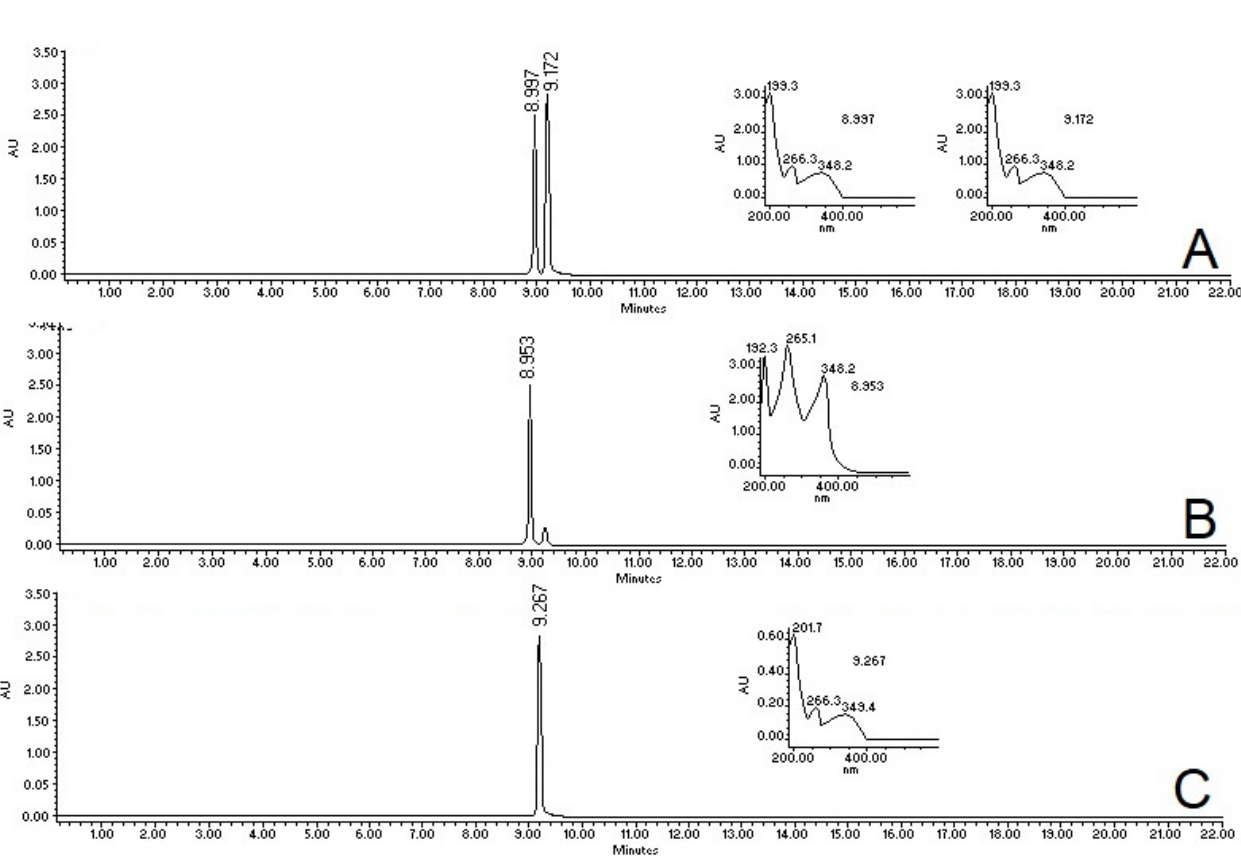
Figure 1. The fingerprint of treatment of MaSS ( A ), which was compared with previously isolated kaempferol-3- O -sophoroside ( B ) and kaempferol-3- O -sambubioside ( C ). All samples were recorded at l = 350 nm; AU = absorbance units.